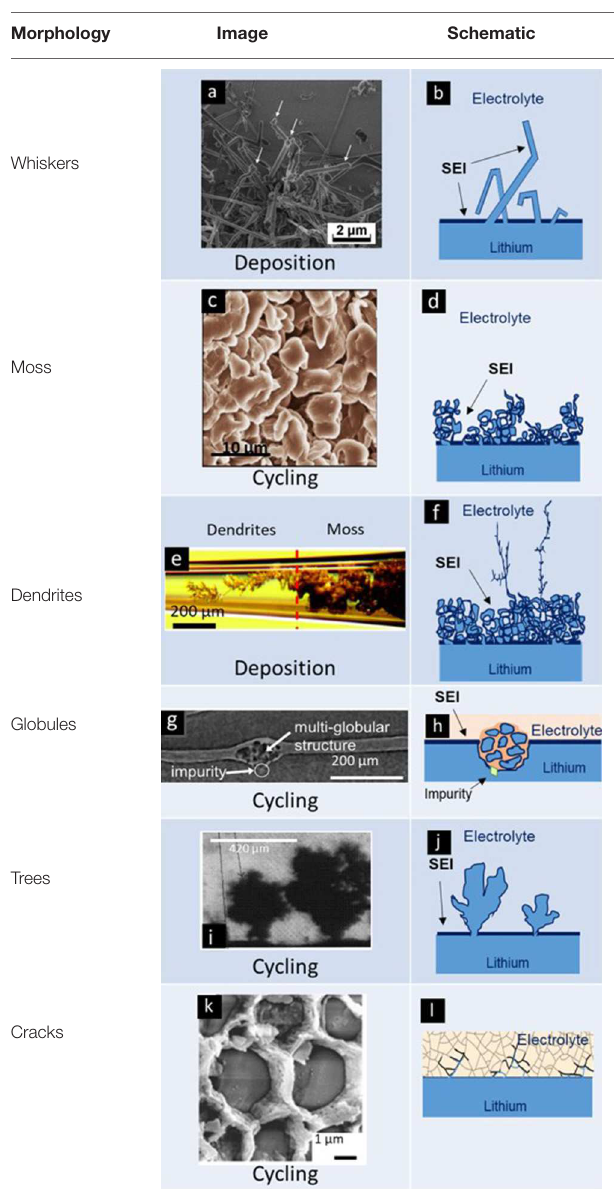
TABLE 1 | Name, experimental visualization, and schematic of common morphologies of electrodeposited lithium. Images of whiskers, mosses, dendrites, globules, trees, and cracks are reproduced with permission from (a) Steiger et al. (2014), (b) Qian et al. (2015), (c) Bai et al. (2016), (d) Harry et al. (2015), (e) Brissot et al. (1998), and (f) Cheng et al.